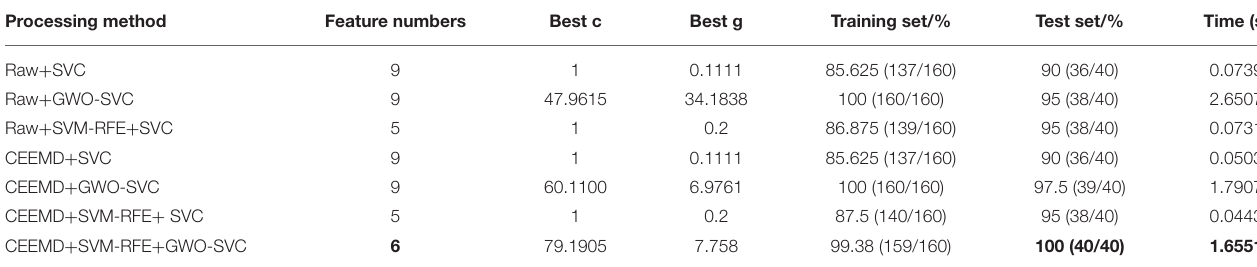
TABLE 4 | Classification results of different treatment methods. Processing method